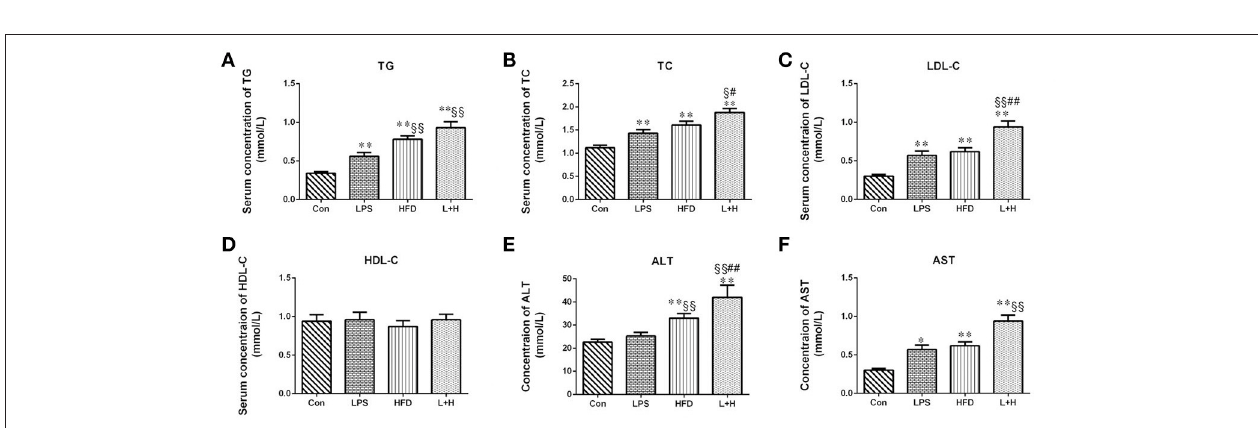
FIGURE 2 | Serum levels of total cholesterol (A) , triglycerides (B) , low-density lipoprotein cholesterol (C) , high-density lipoprotein cholesterol (D) , alanine aminotransferase (E) , aspartate amino transferase (F) in 8-week-old offspring rats. The data are presented as the mean ± SEM. n = 6 in each group. * P < 0.05, ** P < 0.01 vs. control, § P < 0.05, §§ P < 0.01 vs. LPS group, # P < 0.05, ## P < 0.01 vs. HFD group (One-way ANOVA). Con group, male offspring rats treated with prenatal saline and postnatal normal diet from 4 to 8 weeks old; LPS group, male offspring rats treated with prenatal LPS and postnatal normal diet from 4 to 8 weeks old; HFD group, male offspring rats treated with prenatal saline and postnatal high fat diet from 4 to 8 weeks old; L + P group, male offspring rats treated with prenatal LPS and postnatal high fat diet from 4 to 8 weeks